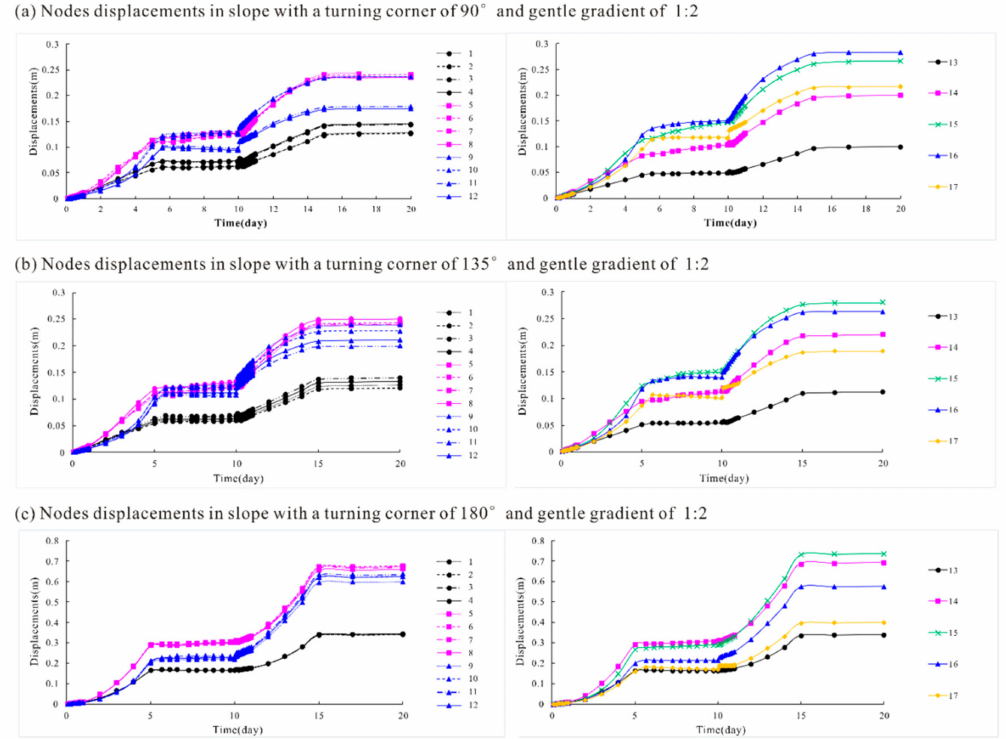
Figure 14. Monitoring node deformations for di ff erent corner angles with a gentle gradient of 1:2: ( a ) turning corner = 90 ◦ ; ( b ) turning corner = 135 ◦ and ( c ) turning corner = 180 ◦